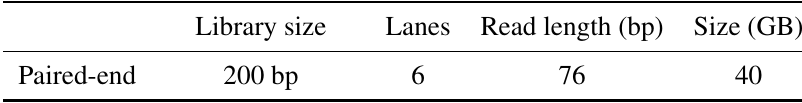
Table 1: The genomic reads and RNA reads generated from homozygous carp using Illumina